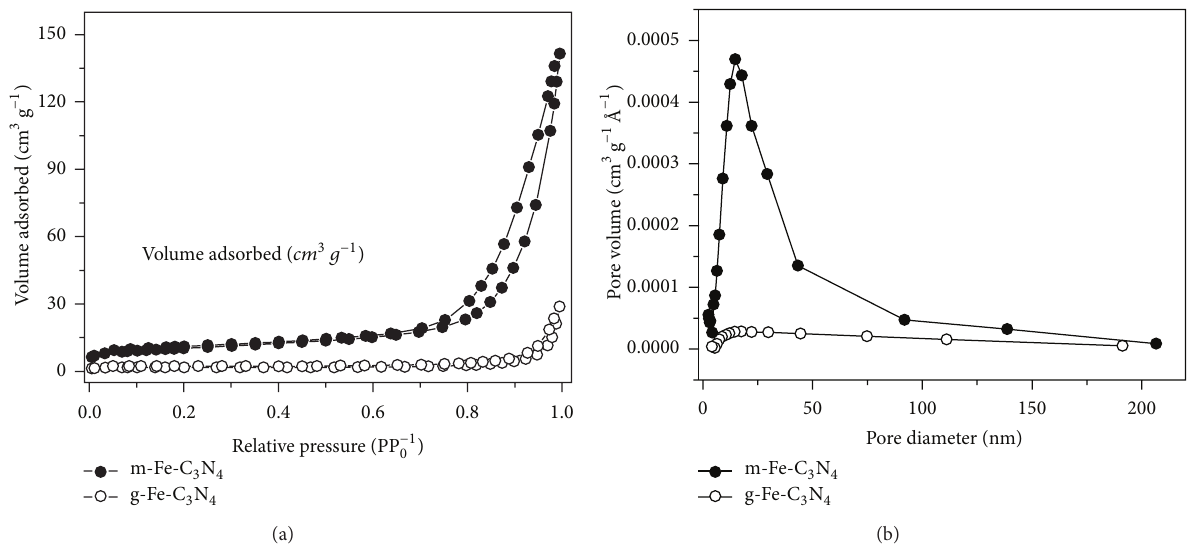
Figure 5: N 2 adsorption-desorption isotherms (a) and Barret-Joyner-Halenda (BJH) pore size distribution plots (b) of g-Fe-C 3 N 4 and m-Fe- C 3 N 4